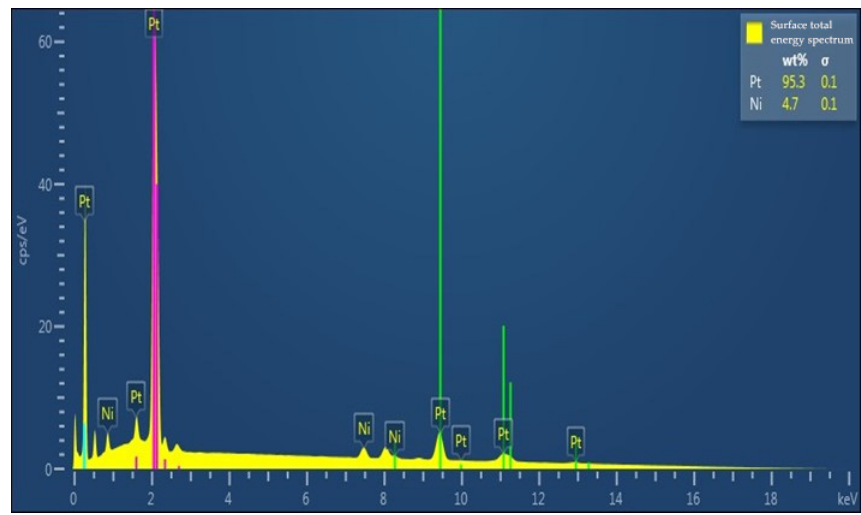
Table 2. Metal composition of PtNi/C from ICP.